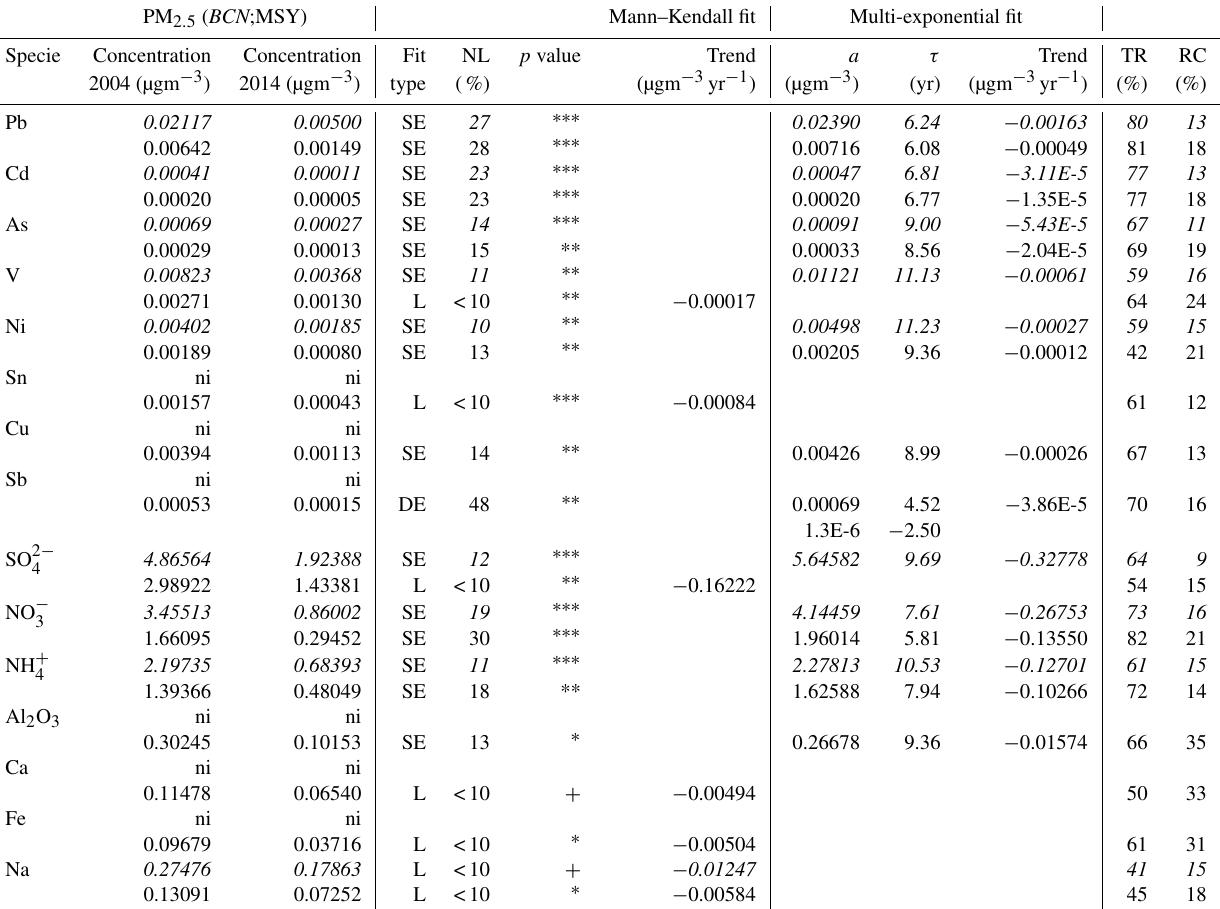
Table 3. Mann–Kendall and multi-exponential trends of different chemical species in PM 2 . 5 at BCN (italic) and MSY. Type of trend: linear (L), single exponential (SE), double exponential (DE); a (µgm − 3 ) and τ (yr) are the constants and the characteristic times, respectively, of the exponential data fittings; NL (%) is the nonlinearity; TR (%) is the total reduction; RC (%) is the residual component; ns denotes not statistically significant; ni denotes not included. Significance of the trends: ∗∗∗ ( p value<0.001), ∗∗ ( p value<0.01), ∗ ( p value<0.05), + ( p